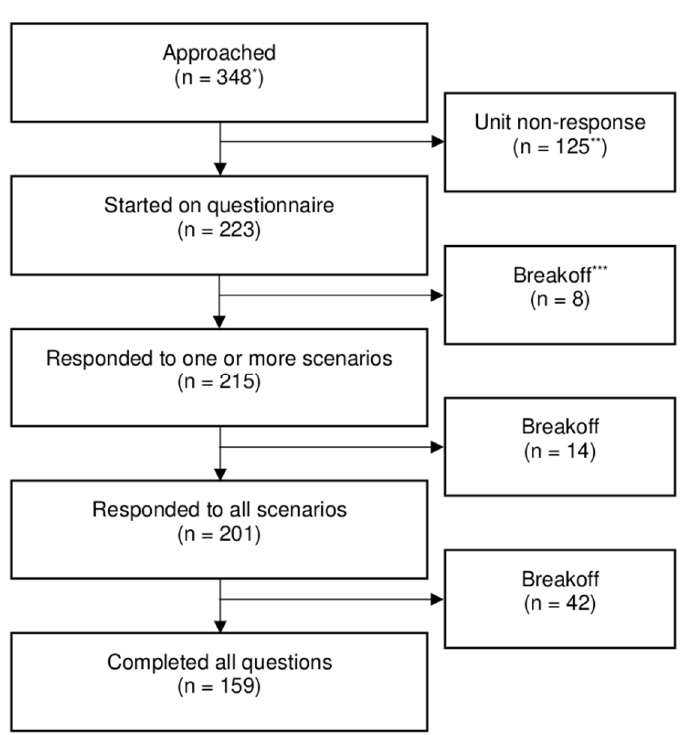
Figure 1. Consort diagram of participants. * Estimated source population (i.e., physicians working at emergency departments in Denmark) from 2014. ** This number includes physicians at the four EDs that refused, the 11 EDs that did not respond to the invitation, and physicians at participating EDs who choose not to participate. *** Respondents started on the questionnaire but failed to complete it resulting in breakoff. Table 2. Characteristics and distribution of physicians indicating gender, age, number of weekly treated patients with intravenous fluids, years of practice and position, and characteristics of hospitals / emergency departments (EDs) indicating location (region), size, complexity, and patient type